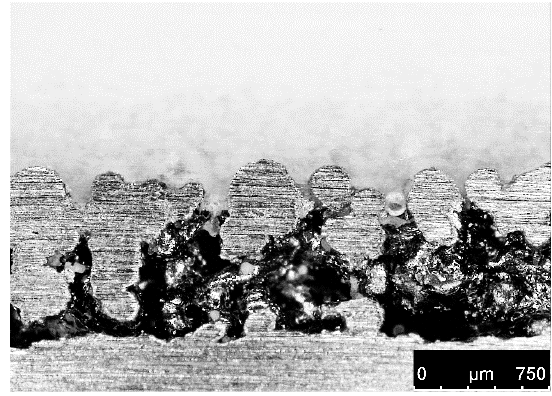
Figure 10. Cross ‐ section of SLM basic plate with molten PA12 (6 exposure cycles). Figure 10. Cross-section of SLM basic plate with molten PA12 (6 exposure cycles).